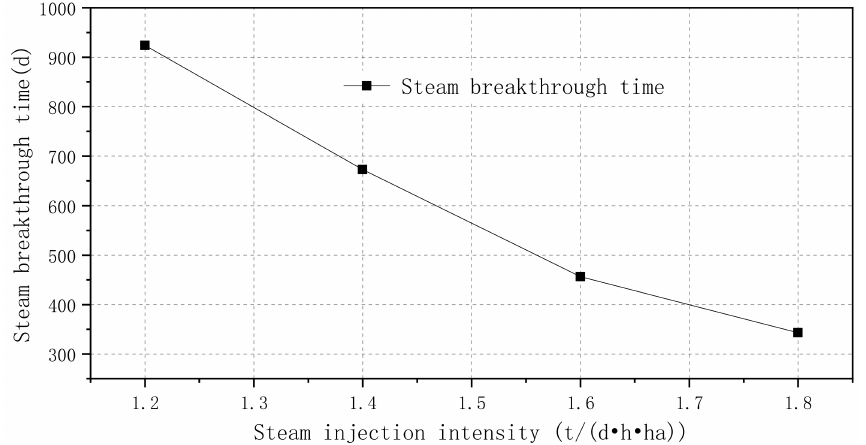
Figure 21. Steam breakthrough time for different steam injection